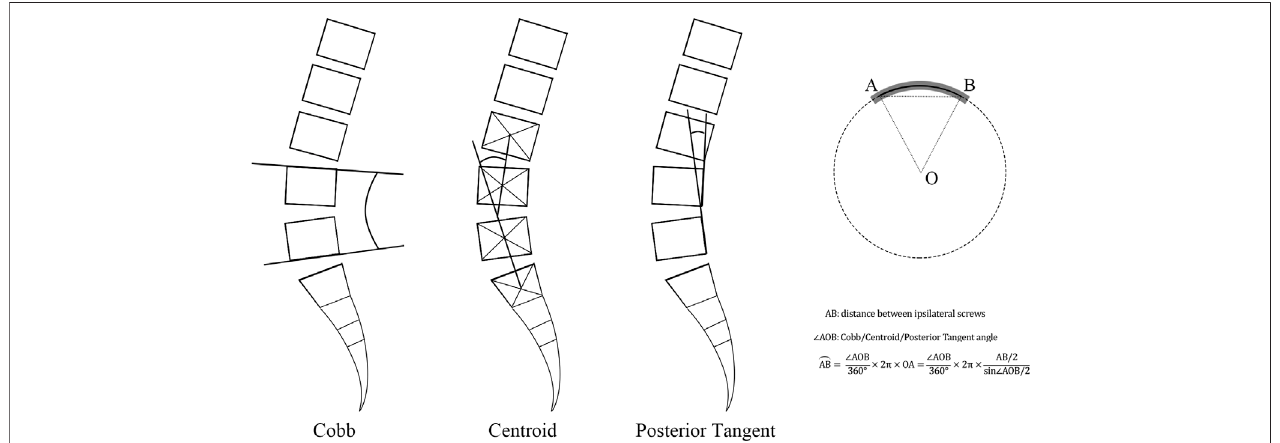
FIGURE 2 | Description of Cobb, centroid, and posterior tangent methods in the rod bending procedure.